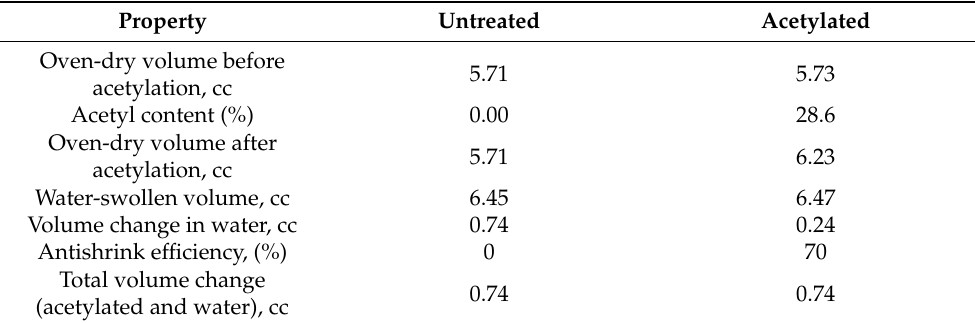
Table 8. Volumetric changes in the acetylated spruce–water relationship [9]. Property Untreated Acetylated Oven-dry volume before acetylation,